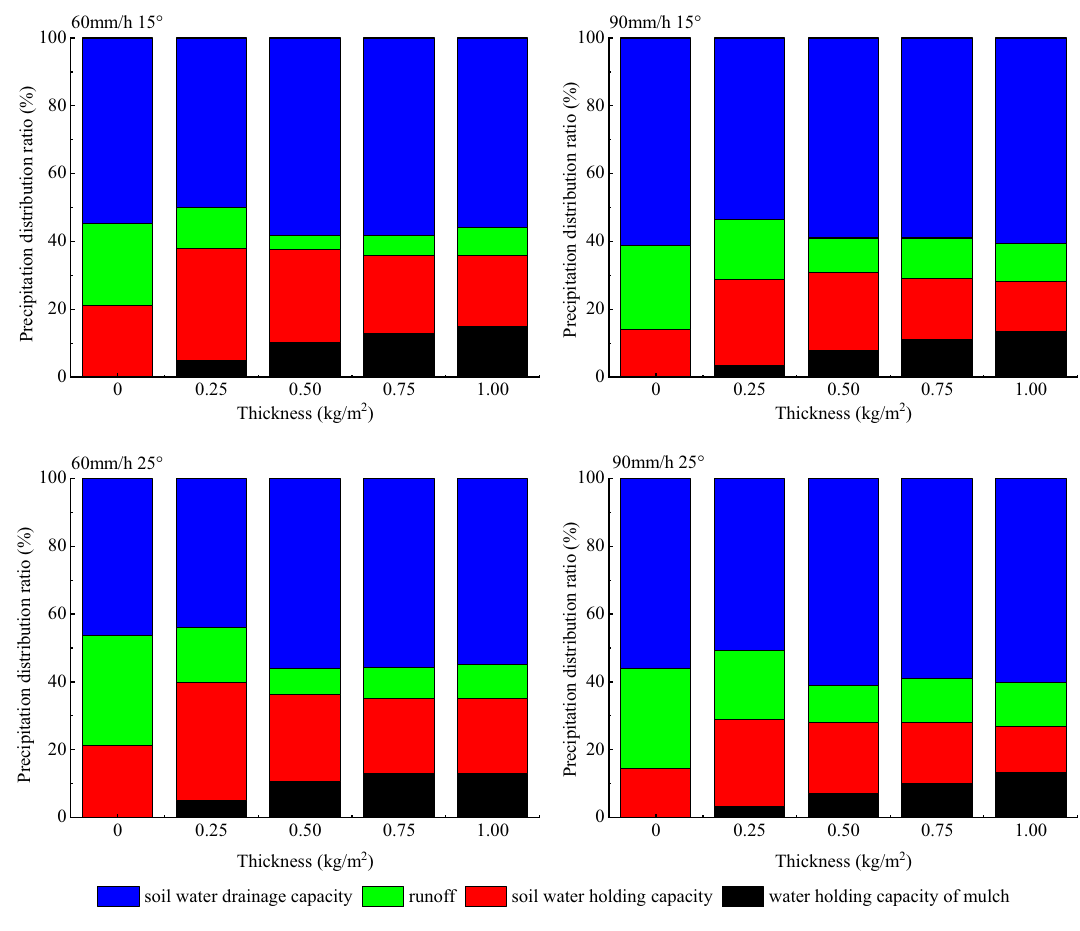
Figure 6. Precipitation distribution into water balance